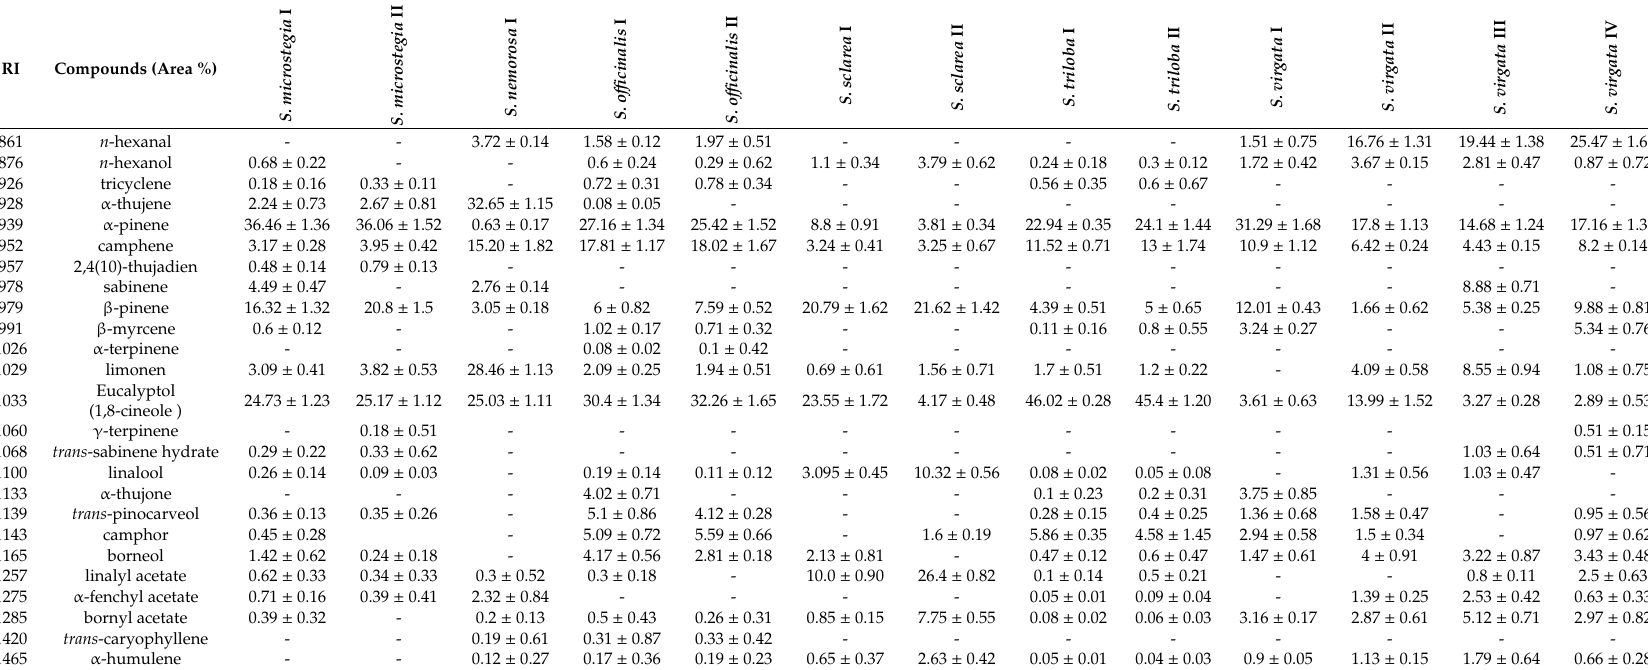
Table 1. The percentage composition (area %) of identified volatile compounds in investigated the seed samples of Salvia species.